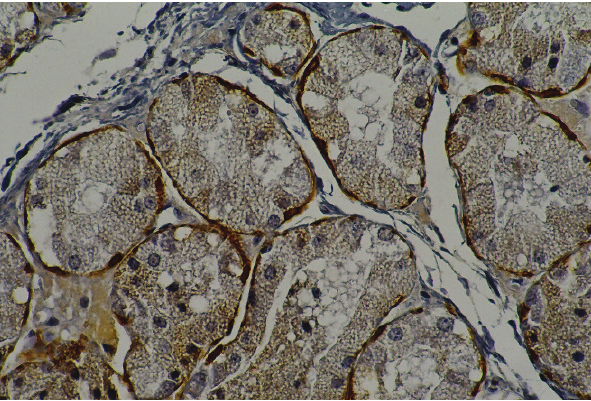
Figure 4 - Immunohistochemical staining of calponin on myoepithelial cells (V30, original magnification